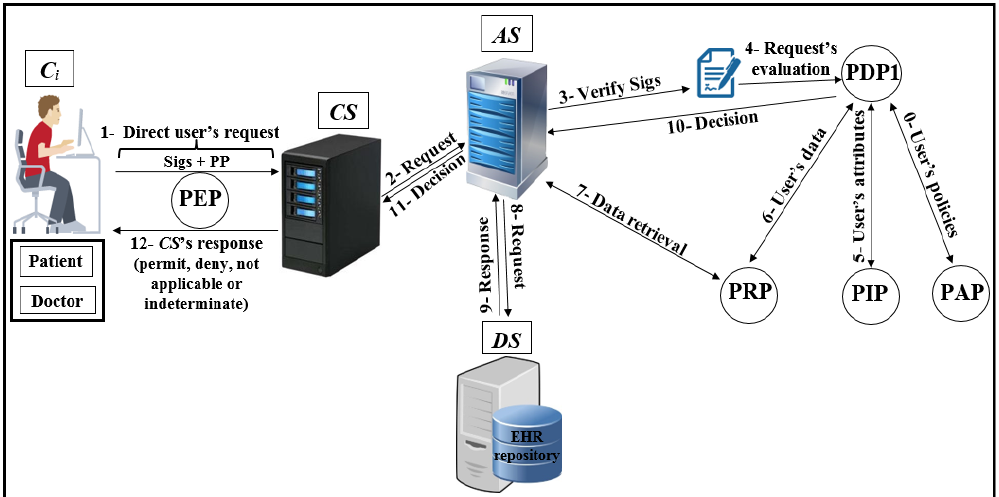
Figure 8. Authorisation of direct